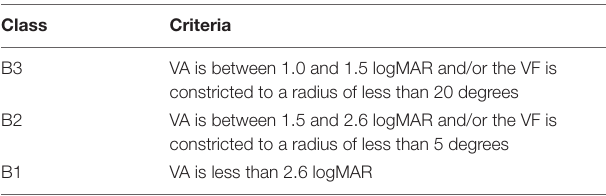
TABLE 1 | The criteria for the three sports classes for athletes with vision